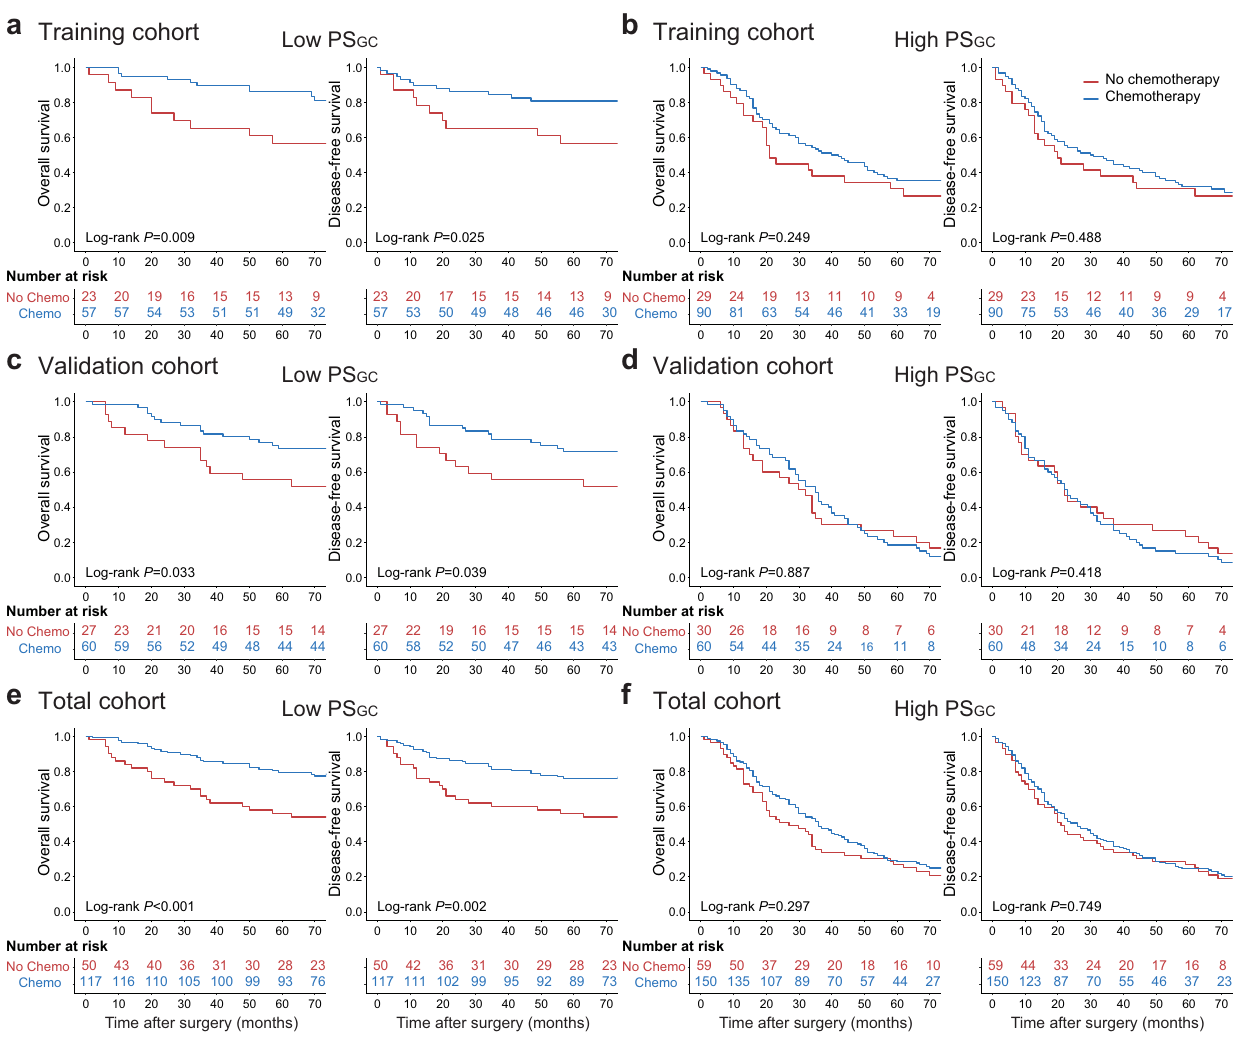
Fig. 4 | Association between the PS GC and survival bene fi ts from adjuvant chemotherapy in stage II and stage III GC. a Survival bene fi ts from adjuvant chemotherapy for the low-PS GC patients in the training cohort. b Survival bene fi ts from adjuvant chemotherapy for the high-PS GC patients in the training cohort. c Survival bene fi ts from adjuvant chemotherapy for the low-PS GC patients in the validation cohort. d Survival bene fi ts from adjuvant chemotherapy for the high-